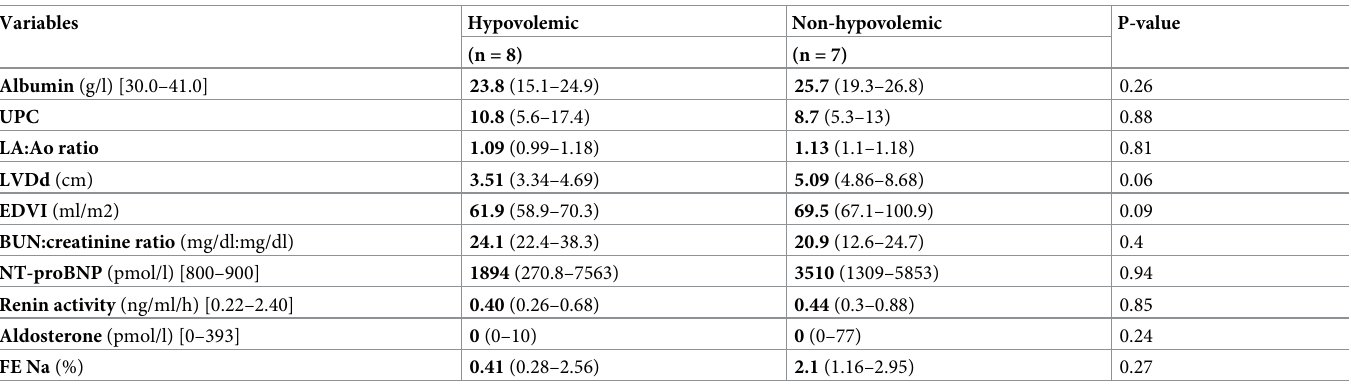
Table 4. Laboratory, echocardiographic, and neuroendocrine variables putatively associated with the vascular volume status of 15 dogs with GD evaluated clinically as hypovolemic or non-hypovolemic. Variables Albumin (g/l) [30.0–41.0]